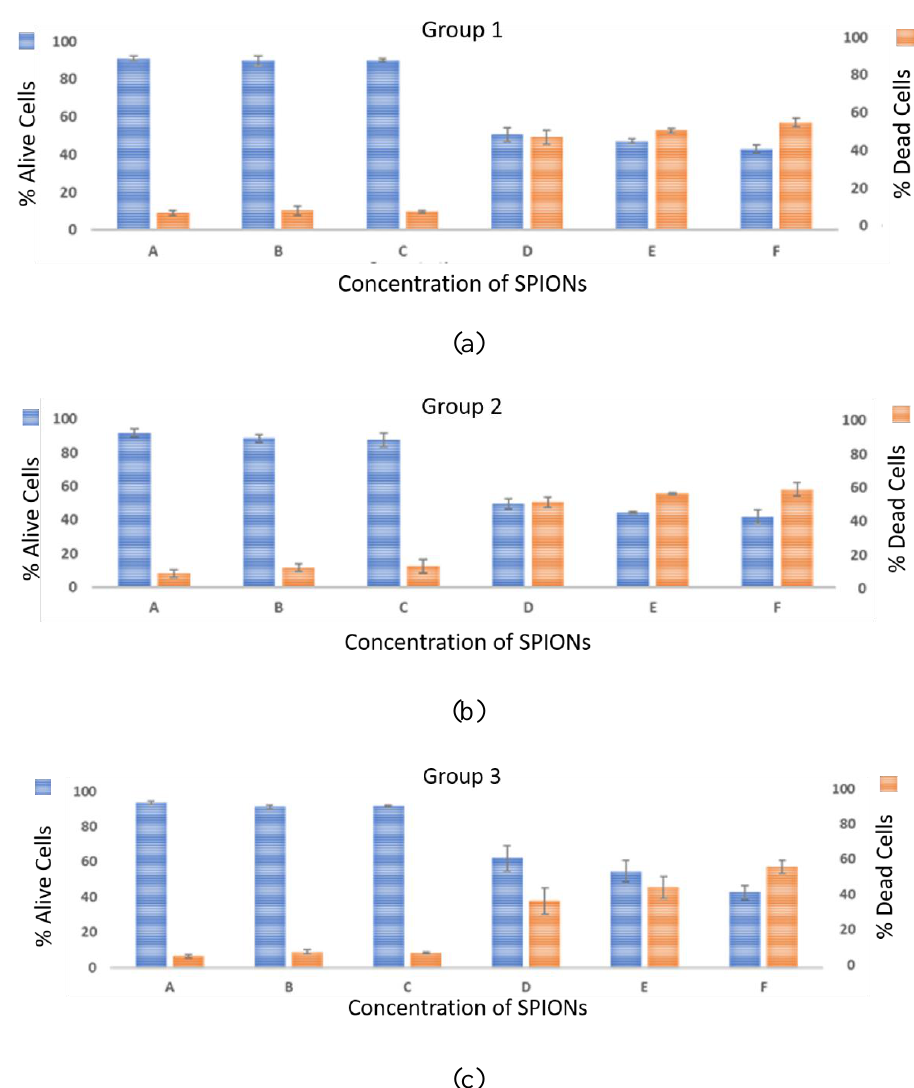
Figure 5. Viability Results. The percentages of both viable and dead N2a cells in the three different ( a ) group 1, ( b ) group 2 and ( c ) group 3 were graphed concerning six different categories A–F. 0, 25, 50, 100, 200 and 300 µg/mL SPIONs concentrations in the first trial.